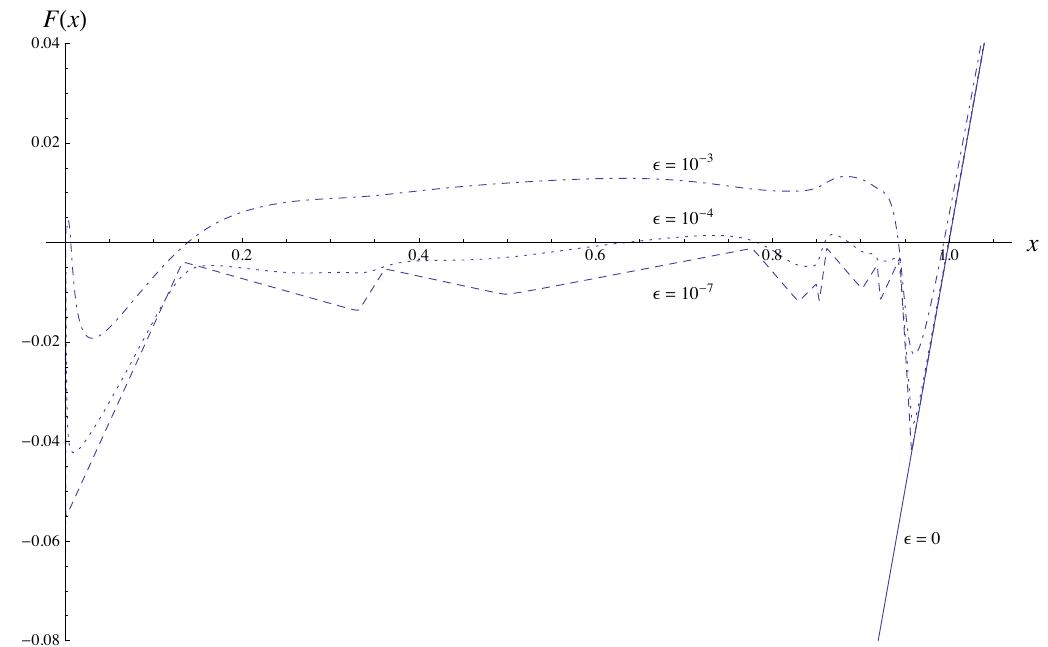
Figure 6. The function F ( x ) for the 5-round PD game with T = 1 . 05 , P = 0 . 15 , and four different mutation rates (cid:15)